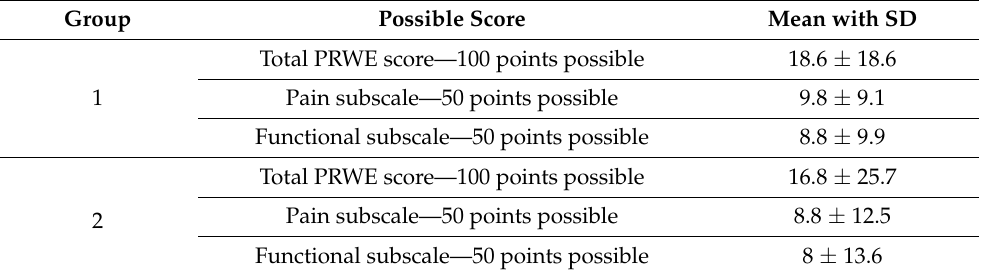
Table 10. Comparison of results of the PRWE